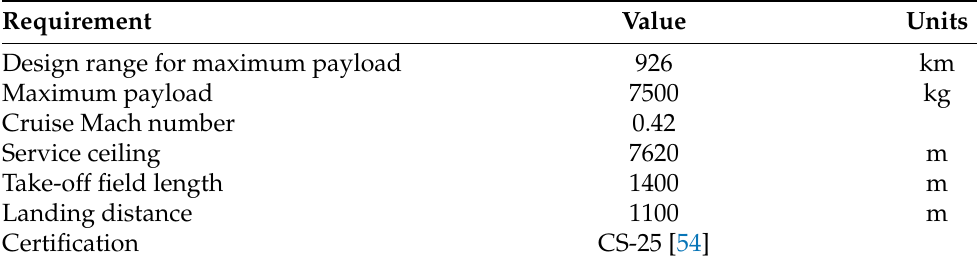
Table 2. SE 2 A SR top-level requirements.